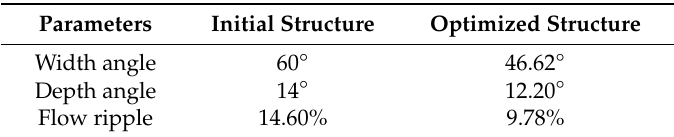
Table 3. Optimized solutions